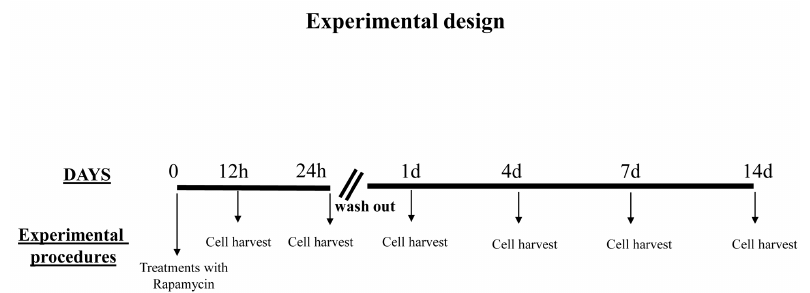
Figure 5. Overview of the experimental design. Rapamycin was administered continuously for 12 h or 24 h to the cell cultures; then, it was withdrawn for 24 h up to 14 d. Thus, the first time interval of rapamycin withdrawal (24 h) is indicated as 1 d and it corresponds to rapamycin administration for 24 h followed by 24 h of withdrawal. All later time intervals are reported considering the days the rapamycin withdrawal time lasted.